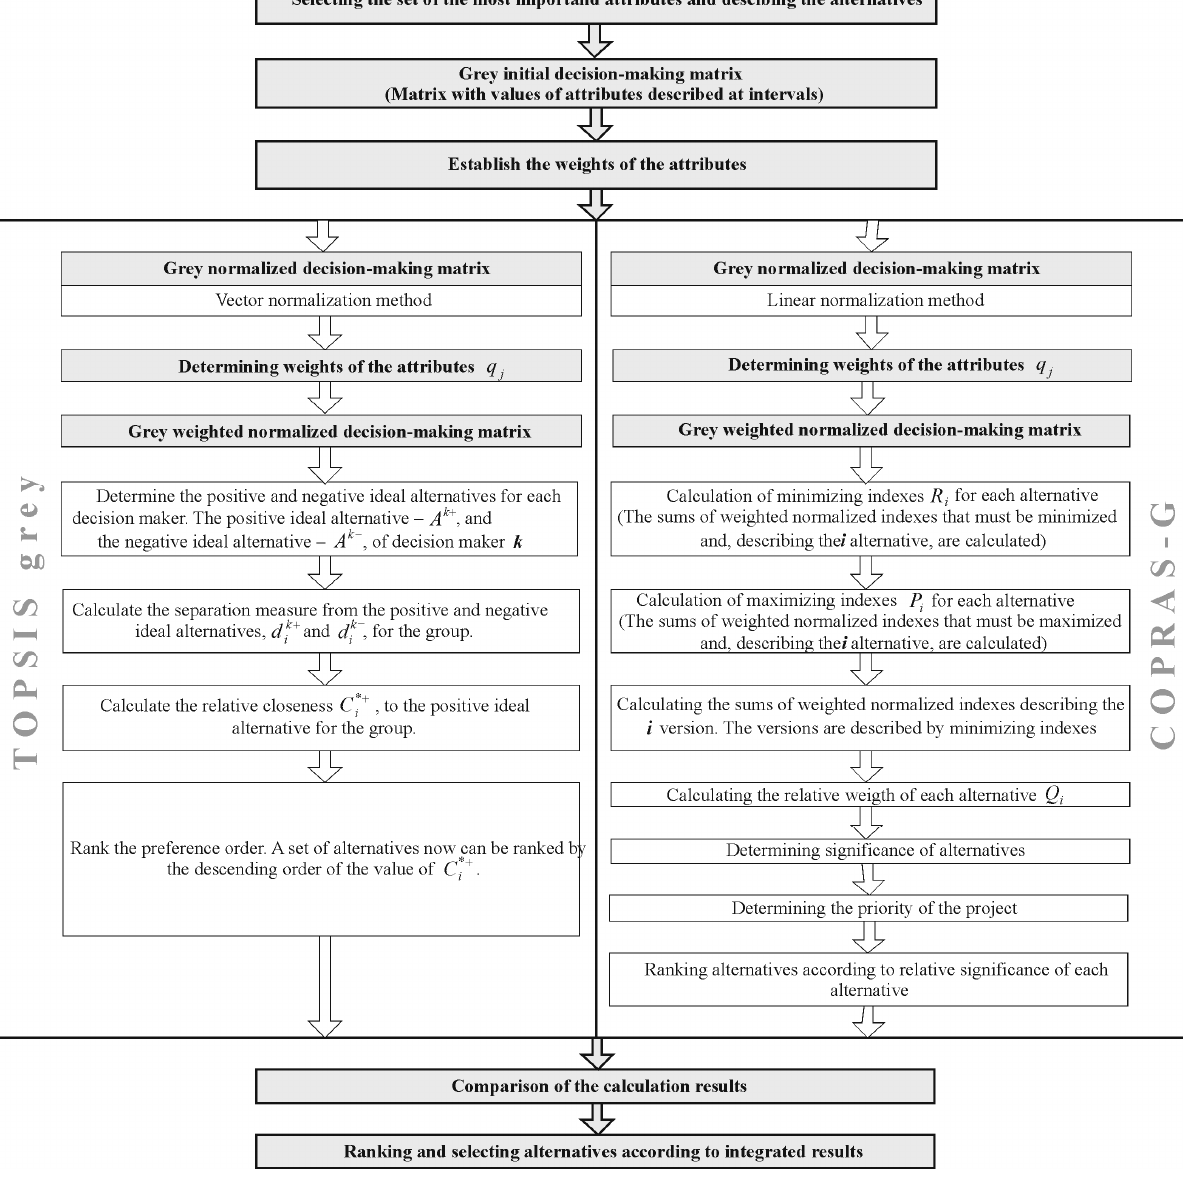
Fig. 5. The main algorithm of problem solution applying TOPSIS grey and COPRAS-G